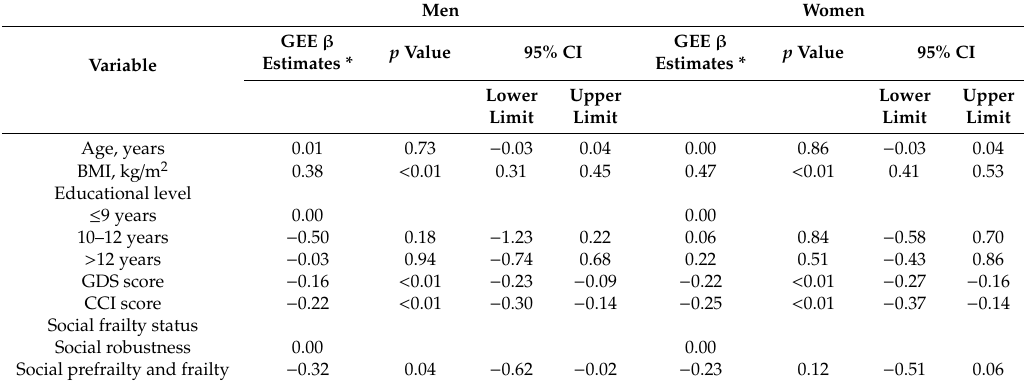
Table 4. Factors influencing longitudinal change based on the Mini-Nutritional Assessment score by sex. Men Women p Value 95% Variable